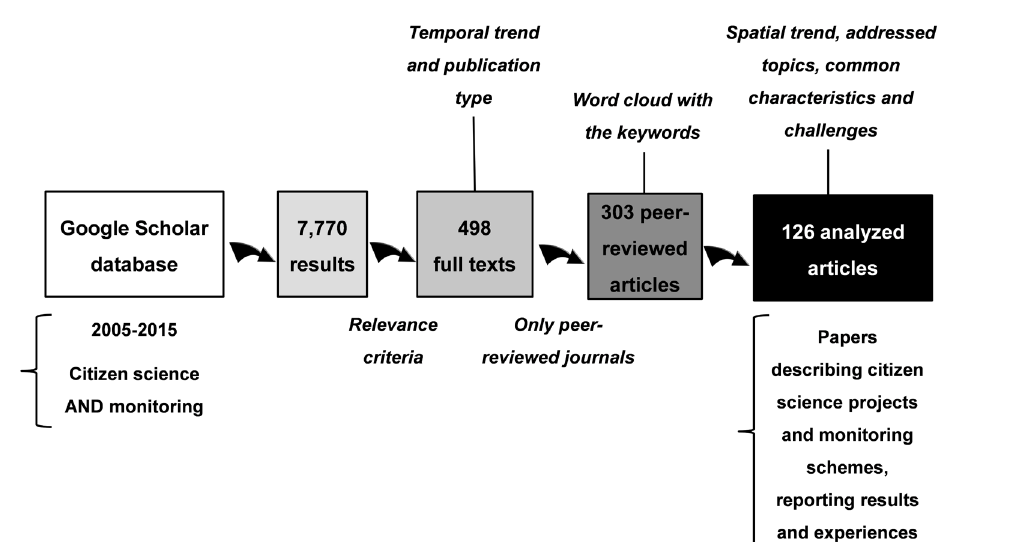
Figure 1 - Literature review using Google Scholar and filtering